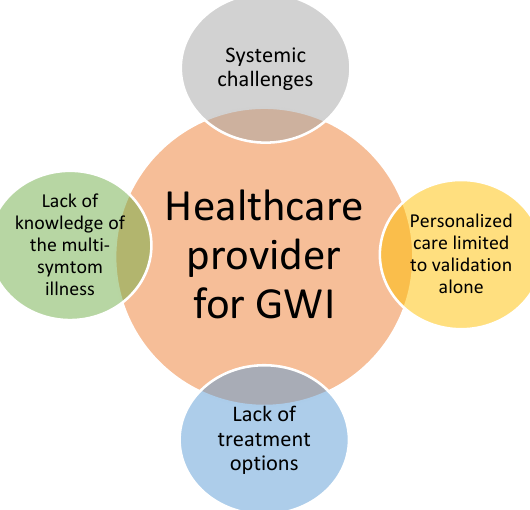
Figure 1. Challenges for healthcare providers serving GWI veterans.